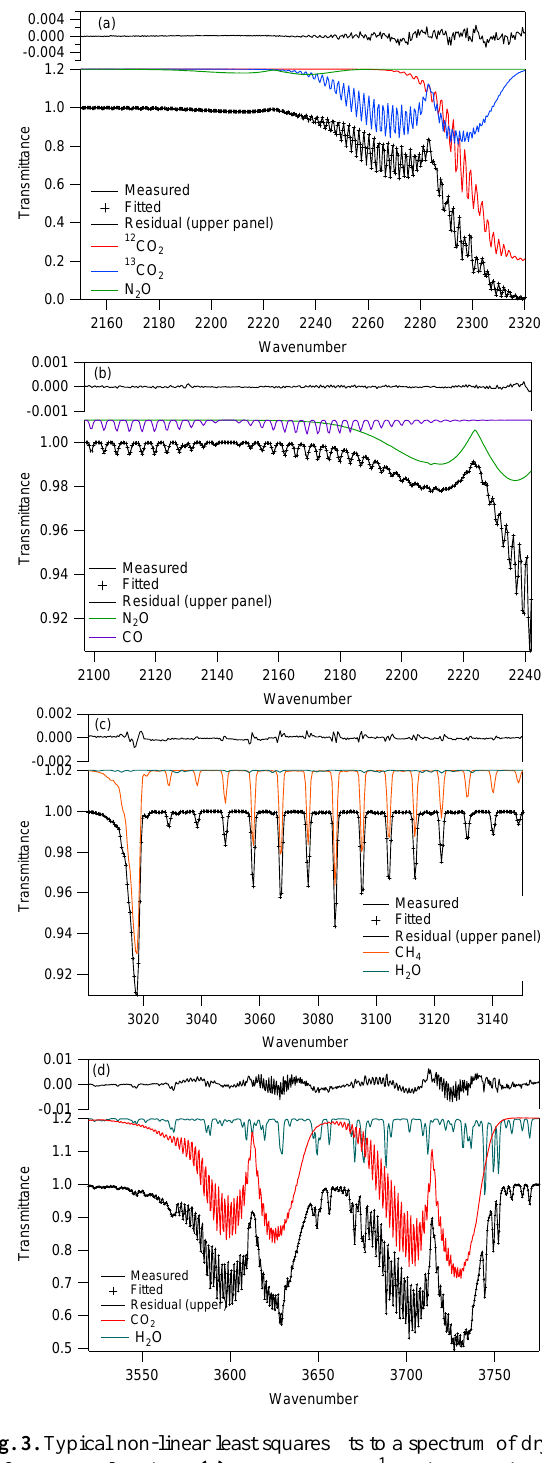
Fig. 3. Typical non-linear least squares fits to a spectrum of dry air in four spectral regions. (a) 2150–2310 cm − 1 , fitting CO 2 isotopo- logues, CO, N 2 O and H 2 O; (b) 2097–2242 cm − 1 , optimised for N 2 O and CO, also fitting CO 2 ; (c) 3001–3150 cm − 1 , fitting CH 4 and H 2 O; (d) 3520–3775 cm − 1 , fitting CO 2 and H 2 O. Contribu- tions from individual species are shown in colours, offset + 0.2 units for